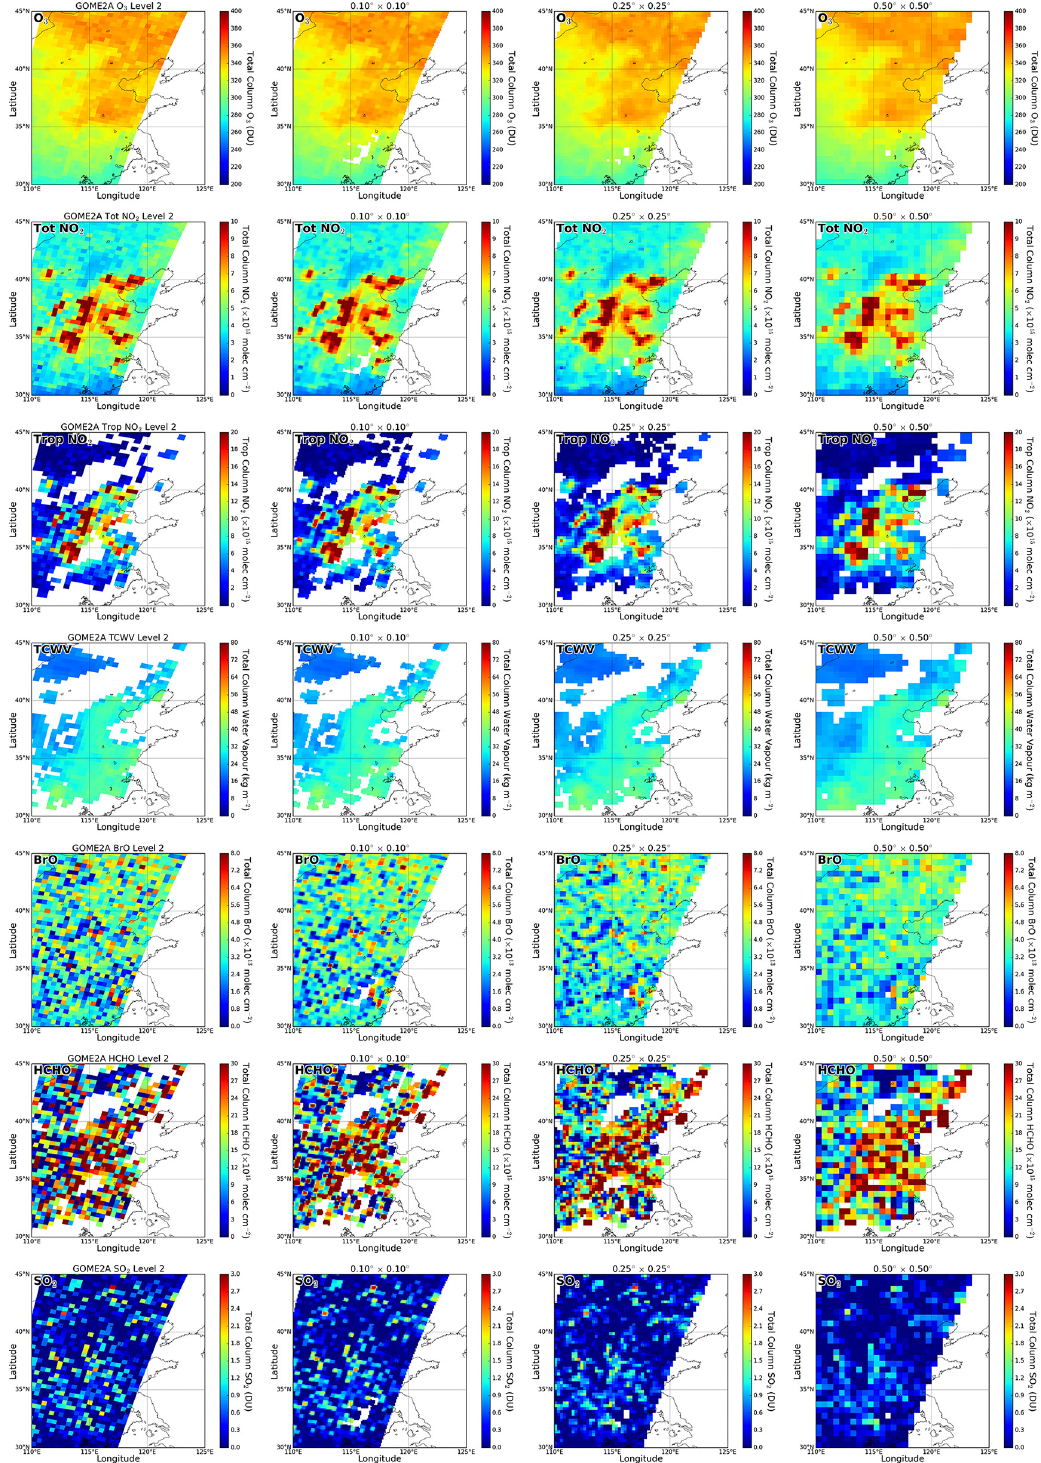
Figure 2. GOME-2A observations of total column O 3 (first row), total column NO 2 (second row), tropospheric column NO 2 (third row), total column water vapour (fourth row), total column BrO (fifth row), total column HCHO (sixth row), and total column SO 2 (seventh row). Data are shown at the original instrument resolution (first column from the left), gridded with 0.1 ◦ × 0.1 ◦ resolution (second column from the left), 0.25 ◦ × 0.25 ◦ resolution (third column from the left), and 0.5 ◦ × 0.5 ◦ resolution (column on the right). GOME-2A observations on 15 July 2014 over North China are shown. Missing data are mainly due to